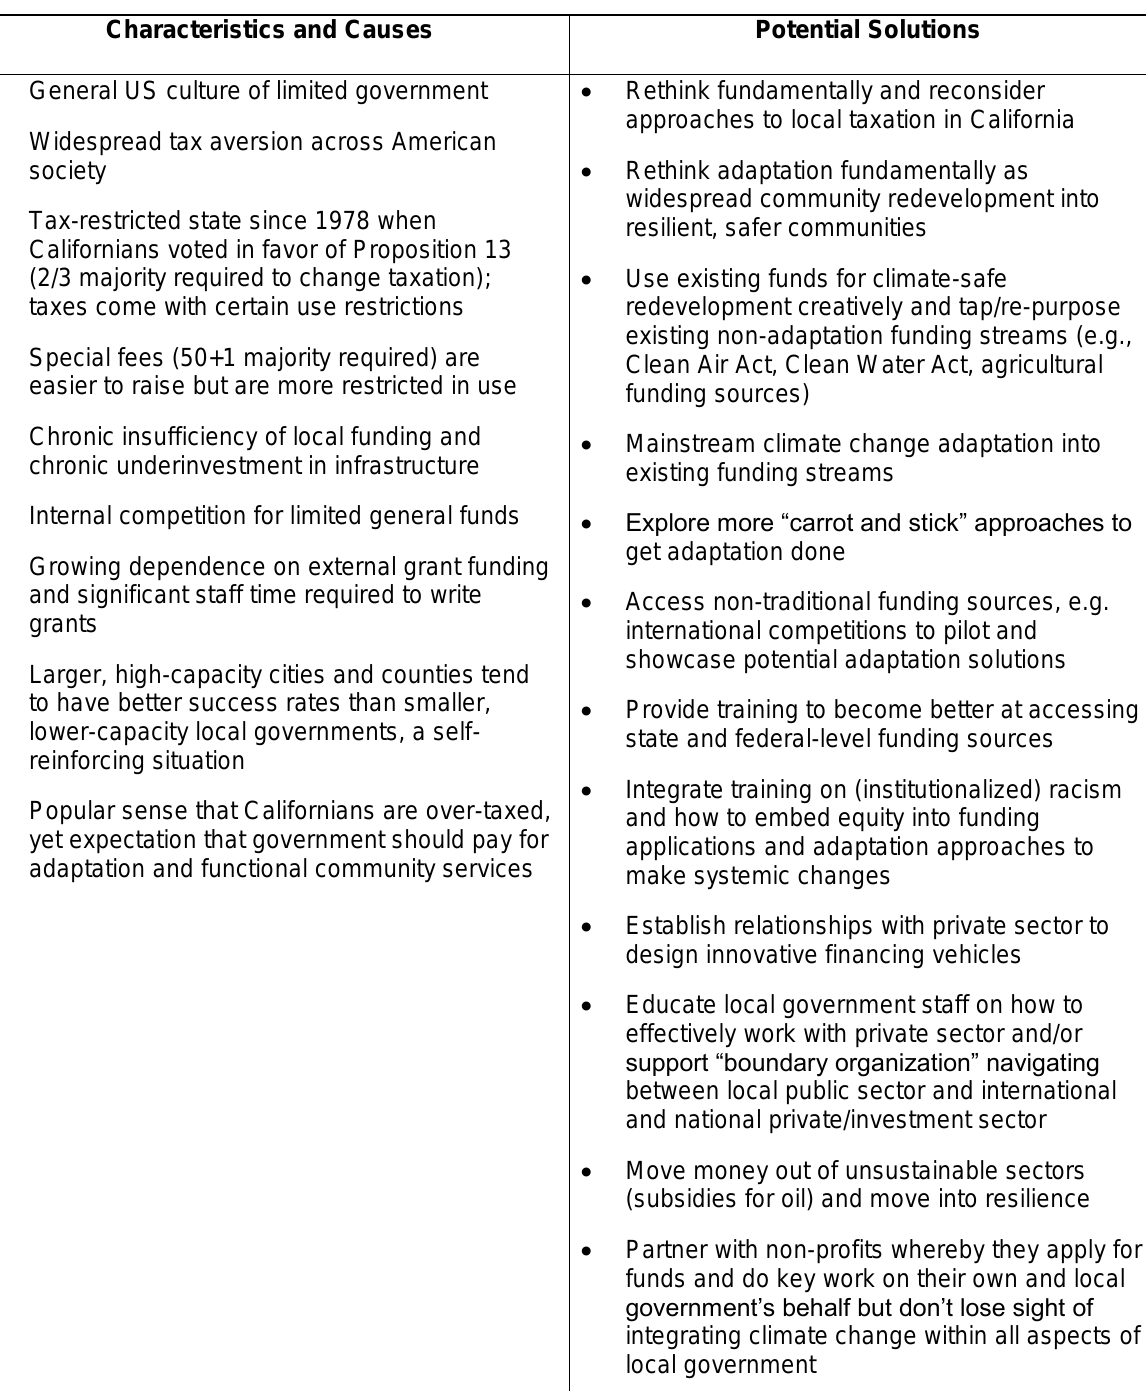
Table A2.8: Characteristics, Underlying Causes and Potential Solutions to Address the Chronic Underfunding